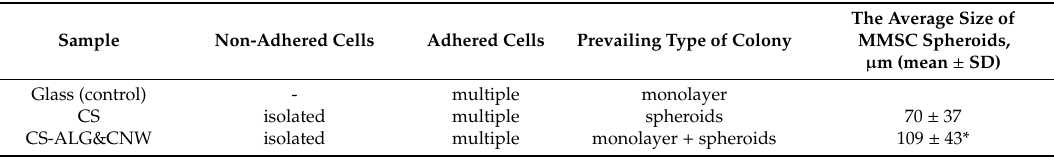
Table 4. Characteristics of multipotent mesenchymal stem cells (MMSCs) and cell colonies formed on di ff erent sca ff olds at 3 days after